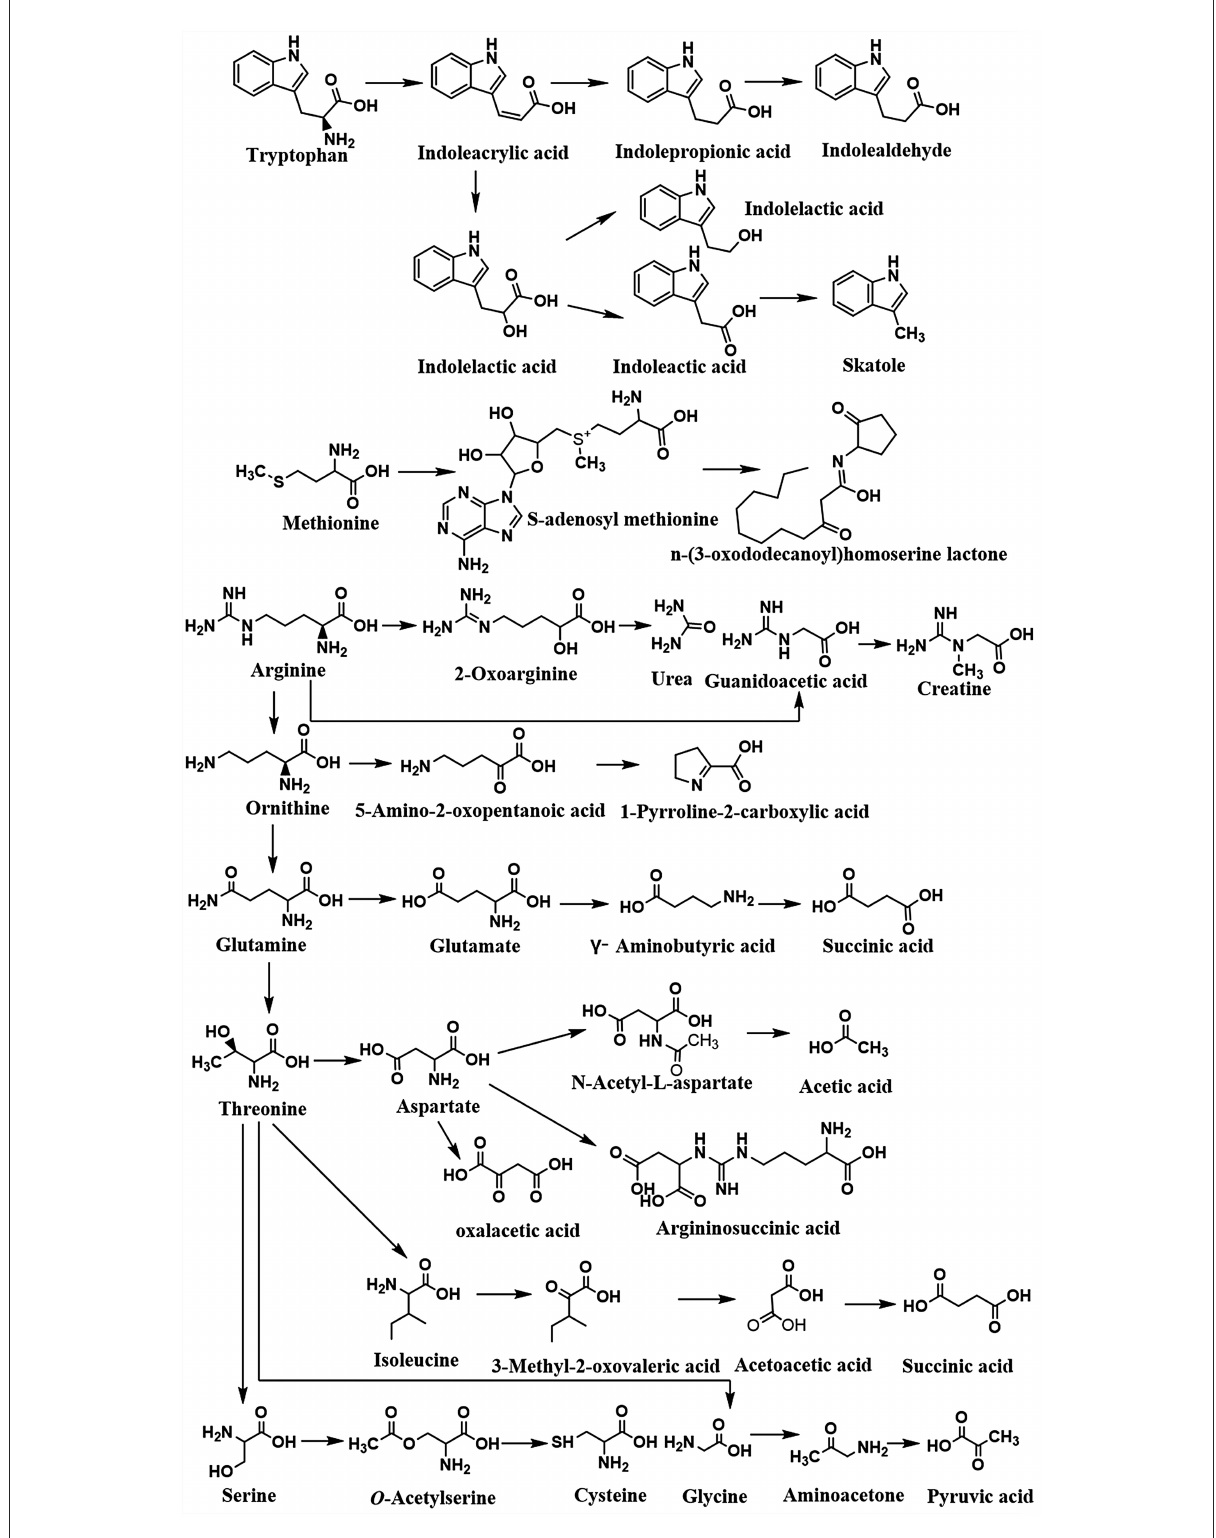
FIGURE4 The summary of microbiota-derived amino acid metabolism